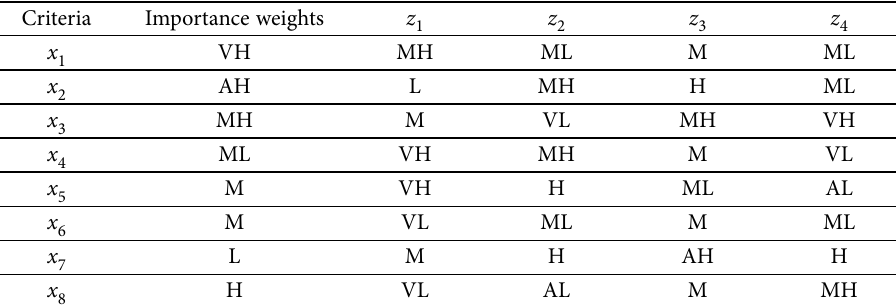
Table 3. Importance weights and linguistic ratings